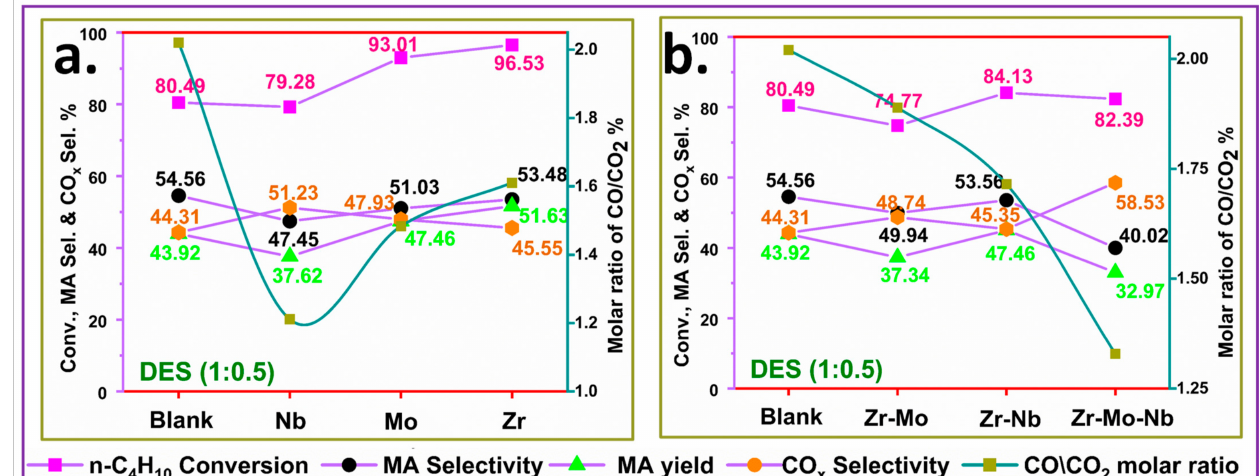
Figure 17. The catalytic performance of mono- ( a ), and bi- and tri-metallic DES-VPO catalysts ( b ) as compared with the unpromoted (Blank-VPO)